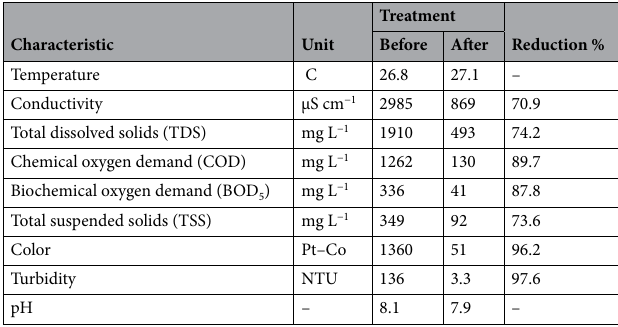
Table 8. Characterization of the textile wastewater before and after